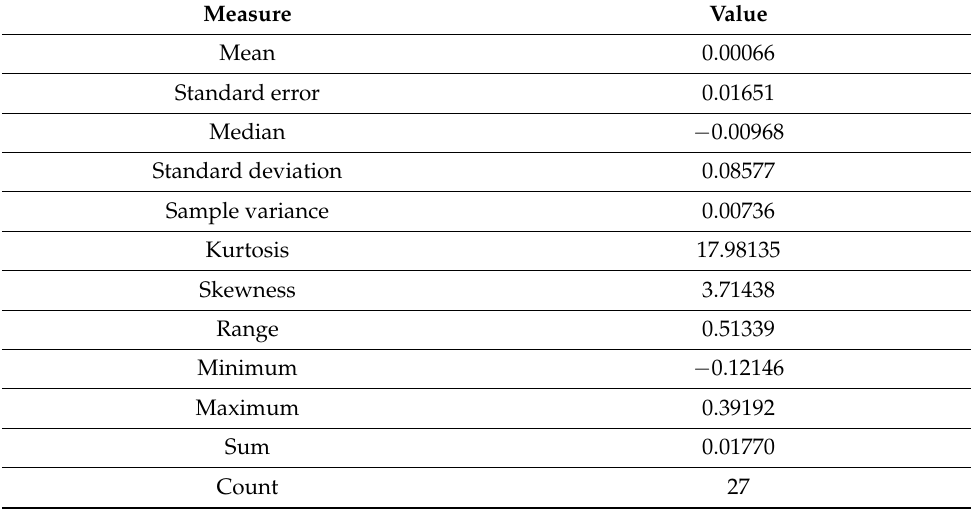
Table 2. Descriptive statistics of DRTs (26 EU member states and the whole EU).